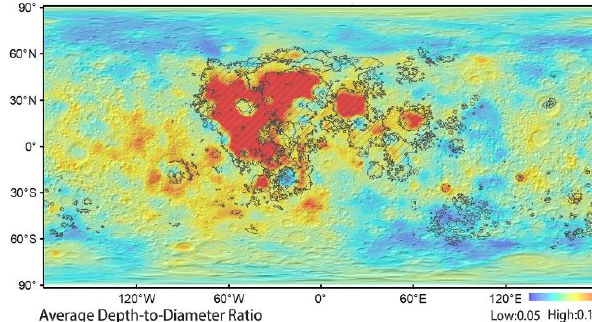
Figure 5. The average depth-to-diameter ratios calculated in a moving window of 100 km radius. The regions of the lunar mare are marked by grey